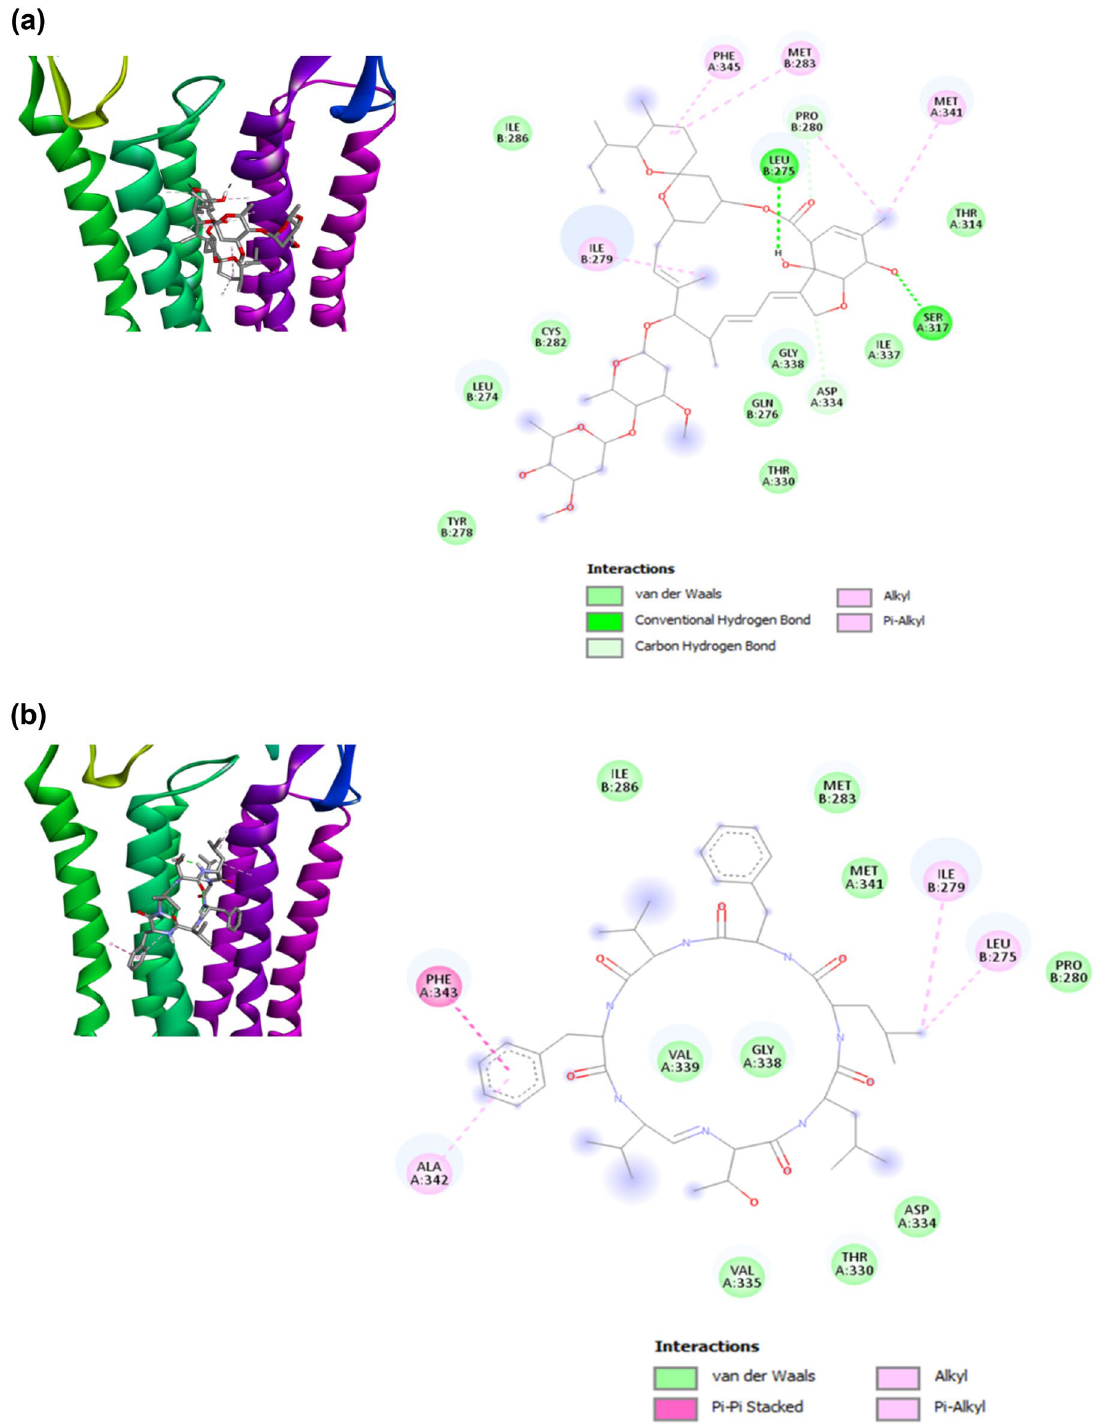
Figure 7. Molecular docking simulation of koranimine and ivermectin with Bursaphelenchus xylophilus α glutamate-gated chloride channel (GluCl) receptor. ( a ) Best docking pose of ivermectin bound to the allosteric site of α GluCl receptor (left) and the ligand-receptor interactions shown in 2D (right). ( b ) Best docking pose of koranimine bound to the allosteric site of α GluCl receptor (left) and the ligand-receptor interactions shown in 2D